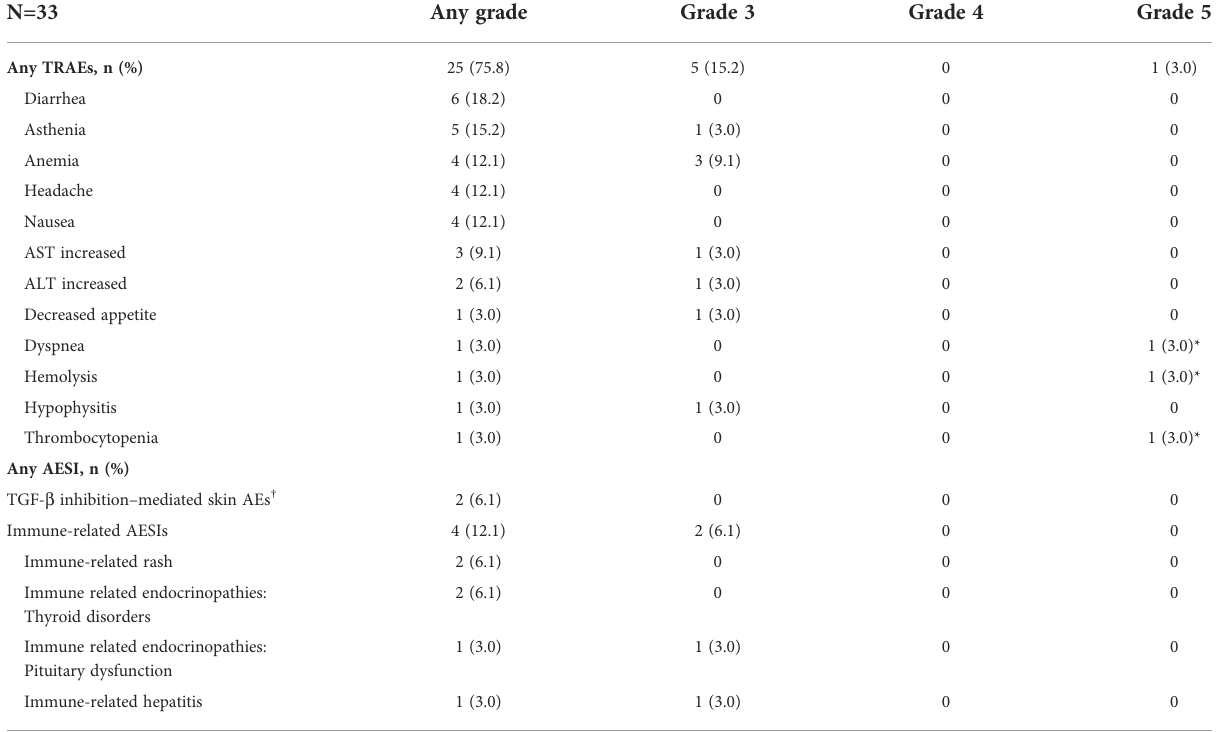
TABLE 3 TRAEs occurring at any grade in <10% of patients, TRAEs occurring at grade <3 and all AESIs.